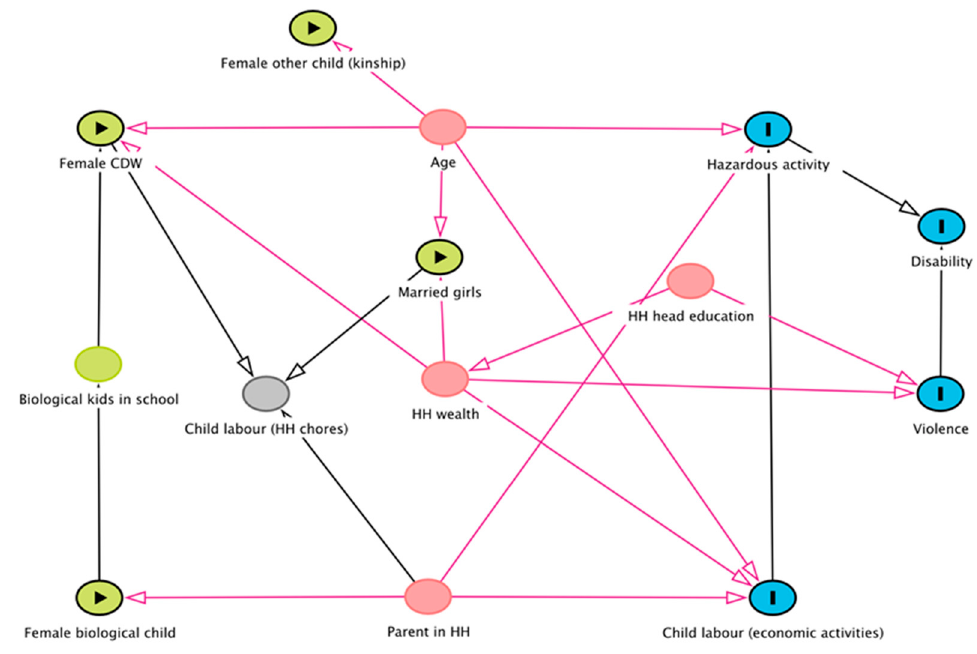
Figure 1. Directed Acyclic Graph of child categories and outcomes.